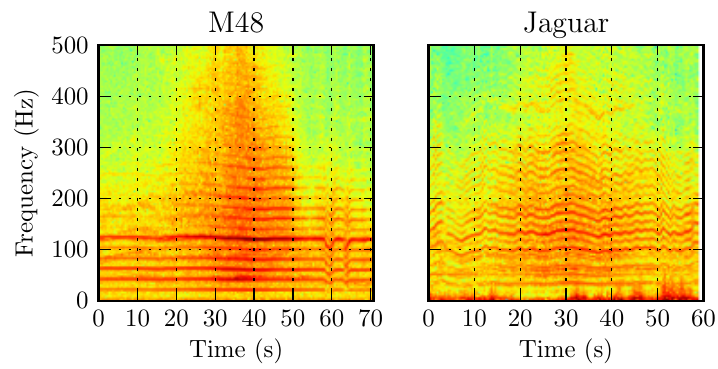
Figure 5. Time-frequency acoustic response of two ground military